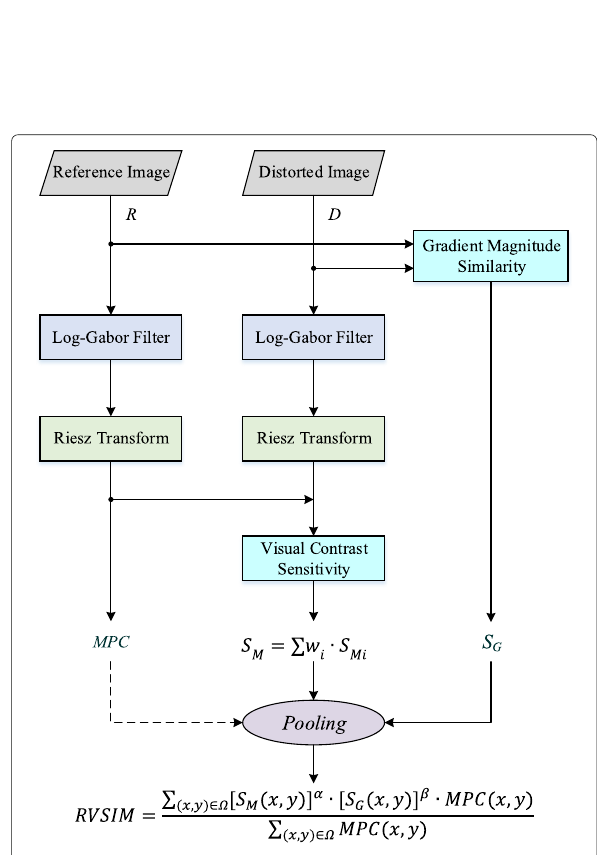
Fig. 5 Illustration of the proposed RVSIM